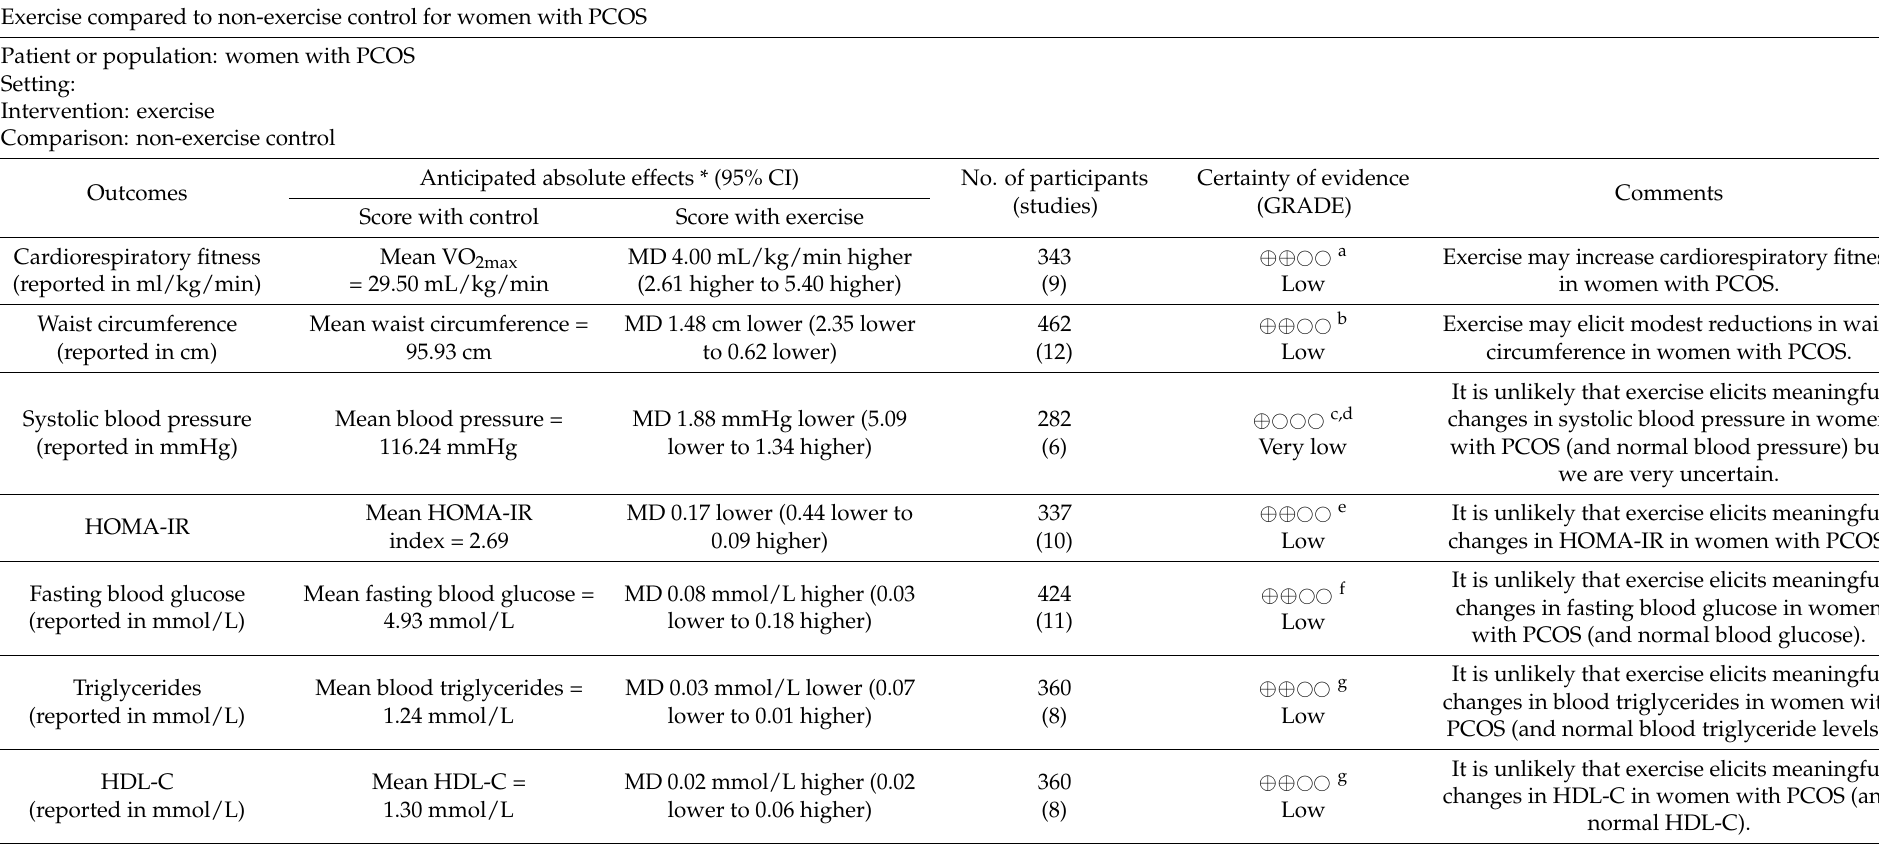
Table 4. Assessment of certainty of evidence